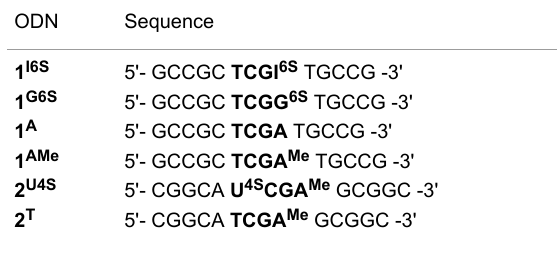
Table 1: ODN sequences used in this study. The M.TaqI recognition sequence is highlighted in bold. A Me = N 6-methyladenine.